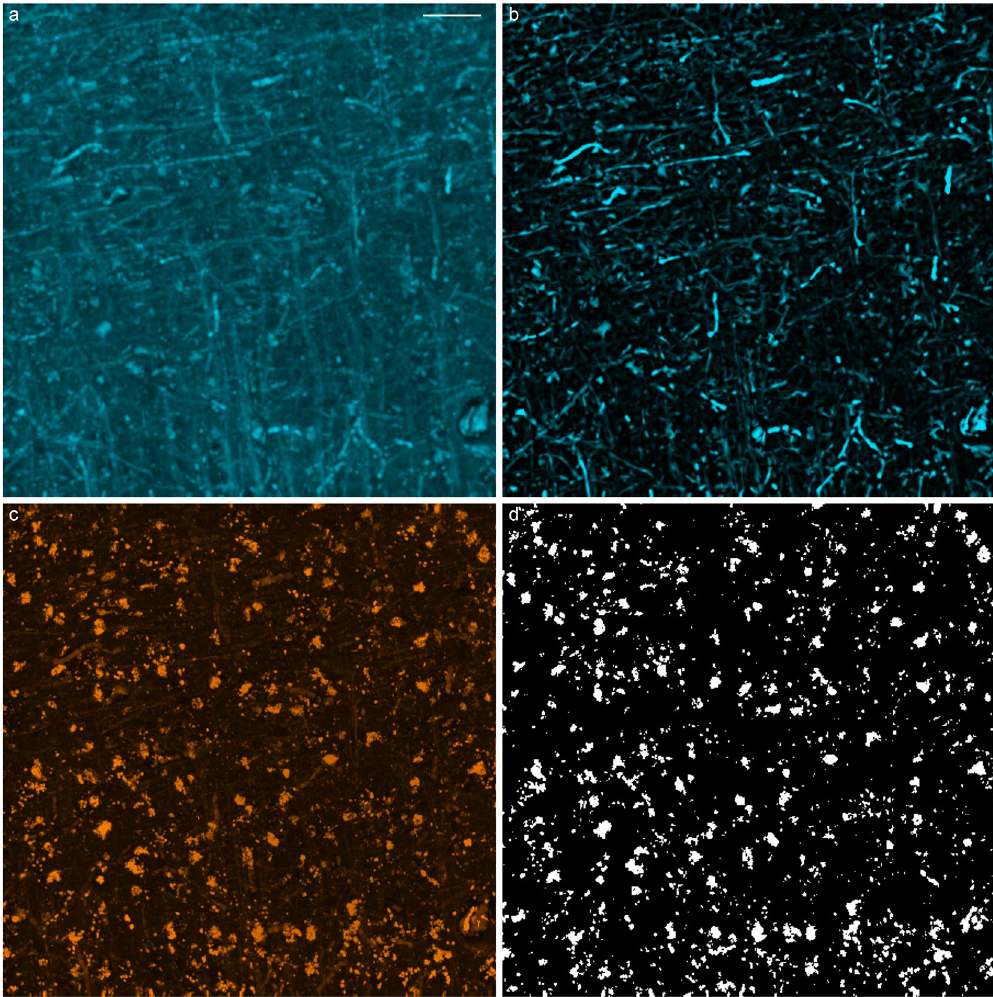
Figure 8. Frangi-based enhancement of myelinated fibers in the 3D TPFM tile shown in Fig. 6 (MIPs, scale bar: 50 µ m ): ( a ) myelinated fibers autofluorescence ( (cid:31) = 482 nm), enhanced via the MAGIC preparation protocol 27 ; 0.001 , β 1 , scales = 1, 1.25, 1.5 µ m ); ( c ) neuronal bodies ( (cid:31) = 618 nm); ( b ) Frangi’s fiber probability map ( α = = ( d ) neuron rejection mask (Yen’s thresholding